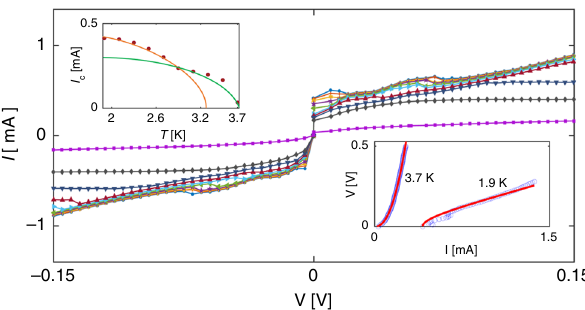
Fig. 4 Current-voltage ( I – V ) characteristics of a Nb-coated superlattice. I – V characteristics for 1.9 – 3.7 K with Δ T = 0.2 K . Right inset: V – I characteristics (open dots) at 1.9 and 3.7 K. Solid line for the 1.9 K data is a fi t to Equation (1). Solid line for the 3.7 K data is a fi t to a power law, yielding V ∝ I 2.3 . Left inset: Critical current derived from the I – V curves as a function of temperature. The error in each point is estimated as 2 – 3%. Solid orange and green lines are guide to the eye, emphasizing the different behavior at high and low state. With increasing voltage, two competing processes determine the current; on the one hand the current follows the voltage increase and on the other hand the current drops as a result of more junctions entering the voltage state. At high enough voltage, all the